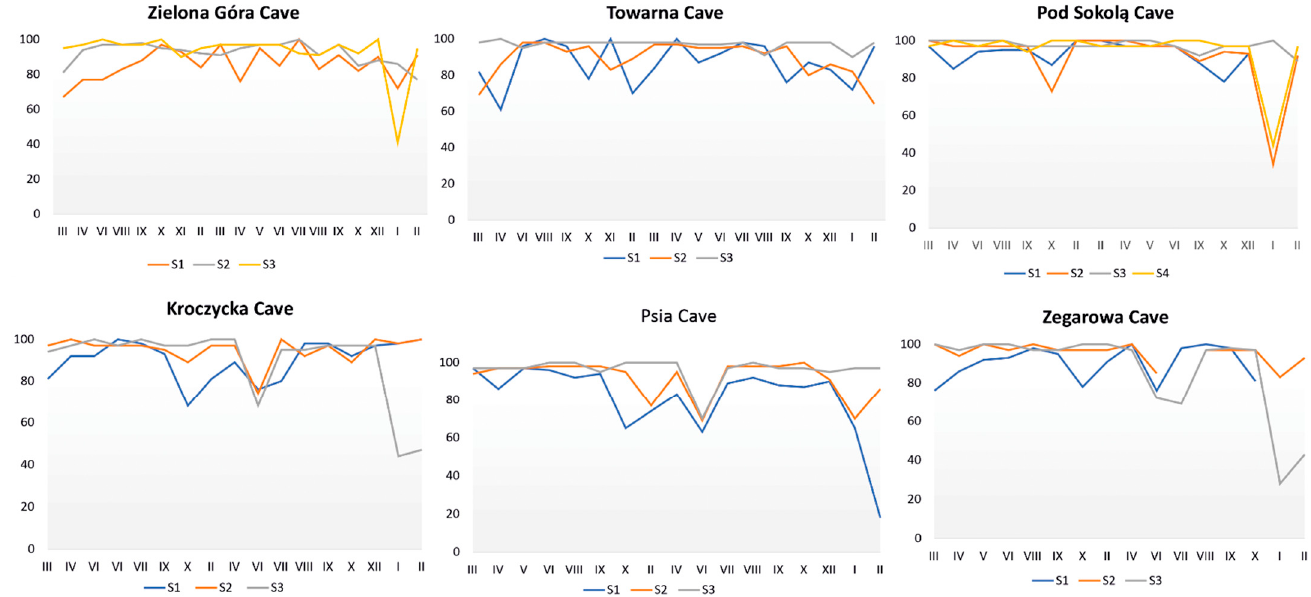
Figure 8. The relative humidity fluctuations at the measurement points in the studied caves.